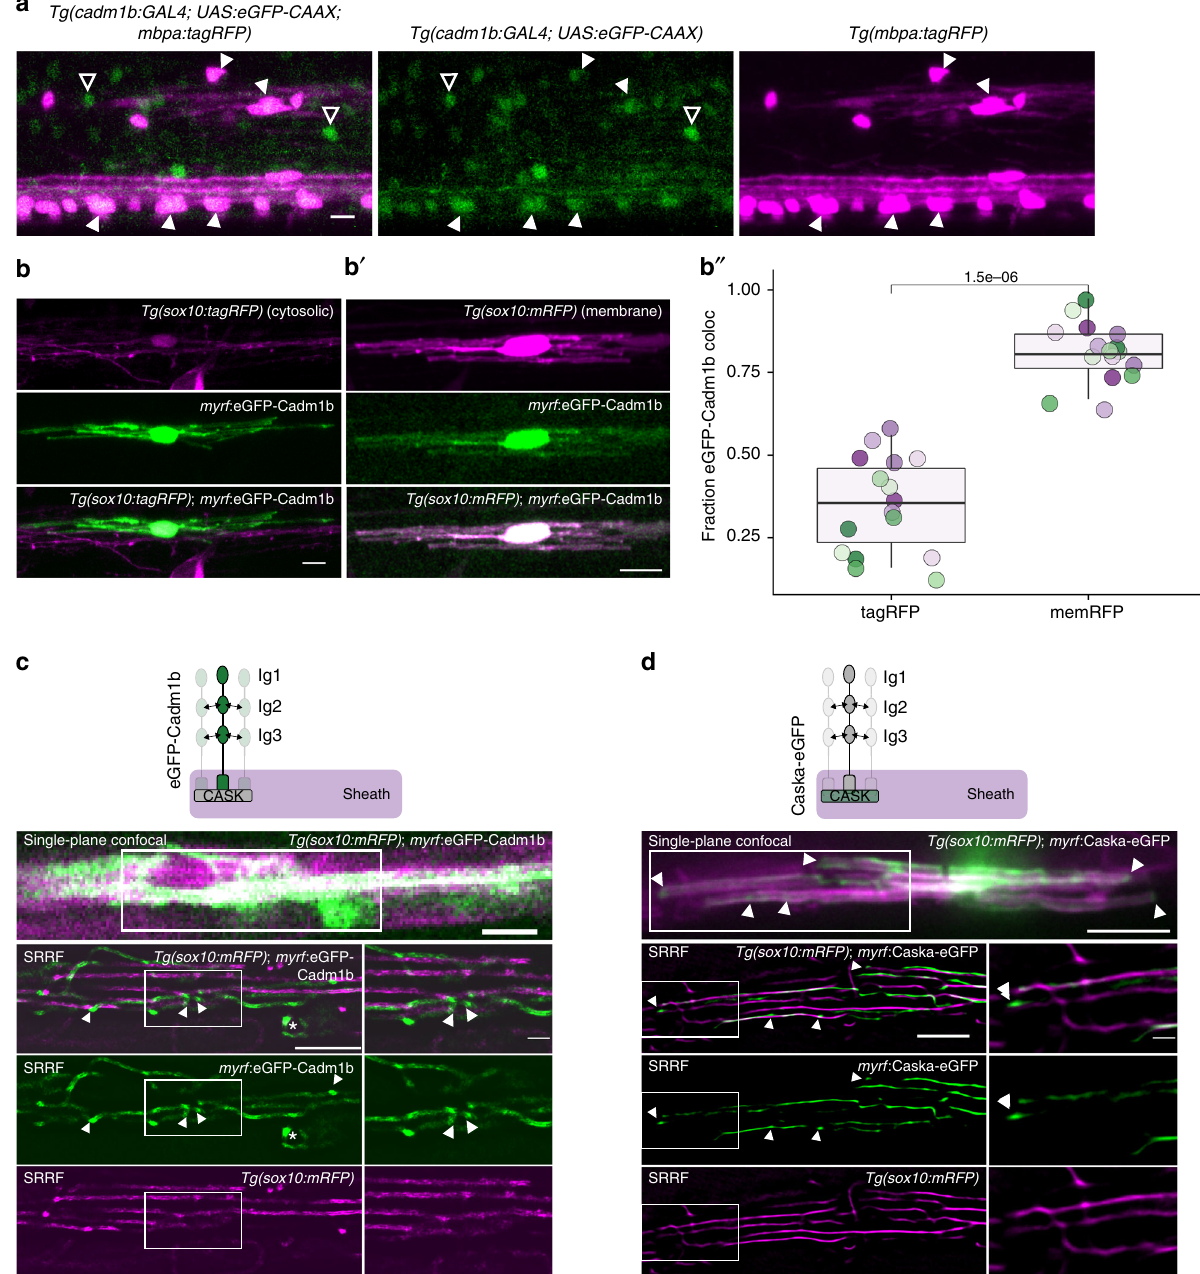
Fig. 5 Cadm1b localizes to myelin sheath membrane. a CRISPR/Cas9-mediated GAL4 enhancer trap of cadm1b reports cells expressing cadm1b via UAS : eGFP-CAAX expression. Larvae additionally carrying Tg(mbpa:tagRFP) reveal mbp + myelinating oligodendrocytes. Closed arrowheads indicate mbp + , cadm1b + oligodendrocytes, whereas open arrowheads indicate mbp -, cadm1b + cells (likely neurons). Scale bar, 10 µ m. b , b ′ ) Expression of myrf :eGFP- Cadm1b in Tg(sox10:tagRFP) ( b ) or Tg(sox10:mRFP) ( c ) co-labeled oligodendrocytes. b ′′ Fraction of eGFP-Cadm1b colocalized with RFP (Mander ’ s colocalization coef fi cient) for Tg(sox10:tagRFP) (tagRFP) and Tg(sox10:mRFP) (memRFP). n = 16 cells (tagRFP), 16 cells (memRFP), Wilcox rank-sum test. Colored dots represent individual cells. c Confocal single-plane (top) and super resolution radial fl uctuations (SRRF) (bottom 3 panels) imaging of a eGFP- Cadm1b expressing oligodendrocyte in a Tg(sox10:mRFP) larva. Arrowheads indicate eGFP-Cadm1b puncta that are not present in mRFP SRRF. Asterisk marks a sheath going in to the plane of view with circular edges surrounded by eGFP-Cadm1b puncta. Scale bars 5 µ m except for innermost inset, 1 µ m. d Similar to c for an oligodendrocyte expressing Caska-eGFP. Scale bars 10 µ m (top), 5 µ m (left SRRF), 1 µ m (SRRF